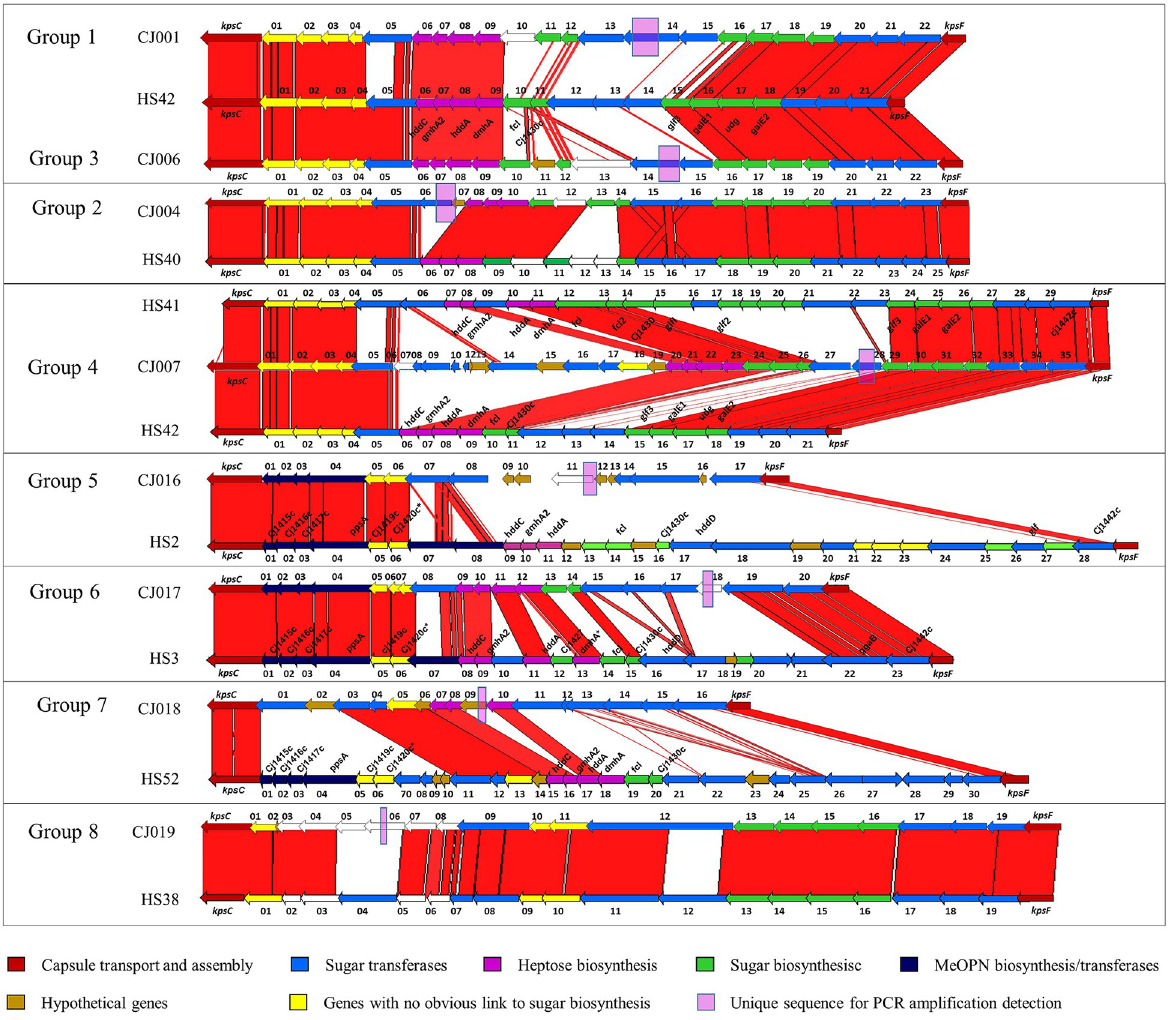
Fig 2. Comparison of 8 CPS sequences, representative of untypeable Campylobacter jejuni groups, to the most similar Penner serotype strains (Poly, F et al ., 2015) [12]. The red vertical bars represent identical regions between loci. The outermost genes (5’ and 3’ of sequences) in red represent kpsC (left) and kpsF (right), two conserved genes in CPS synthesis that bracket the hypervariable CPS loci. The comparison was generated by the Artemis comparison tool (ACT).